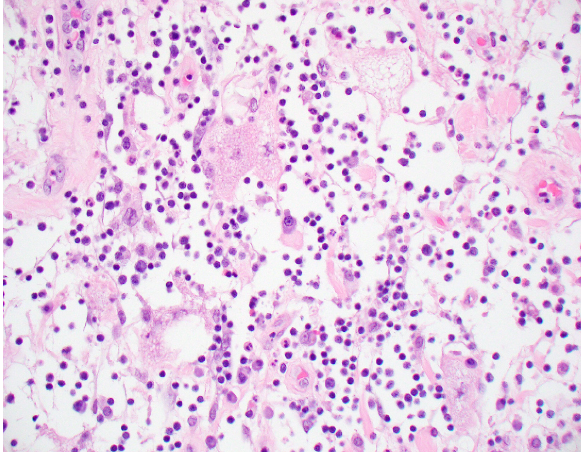
Figure 3: High-power histologic photomicrograph demon- strating scattered brown adipocytes invested by an extensive lymphoplasmacytic inflammatory cell infiltrate (hematoxylin and eosin,